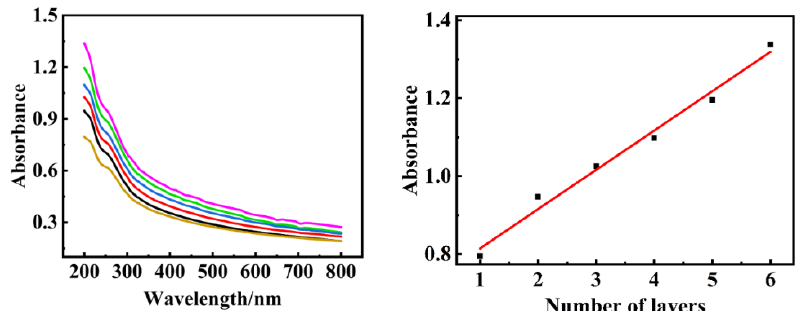
Figure 5. ( left ) UV − vis absorption spectra of the films PDDA/[Ni25/(PDDA − rGO)] n recorded on the quartz slide with the layer numbers increasing from 1 to 6. ( right ) The relationship between the absorbance and the layer numbers at 200 nm.